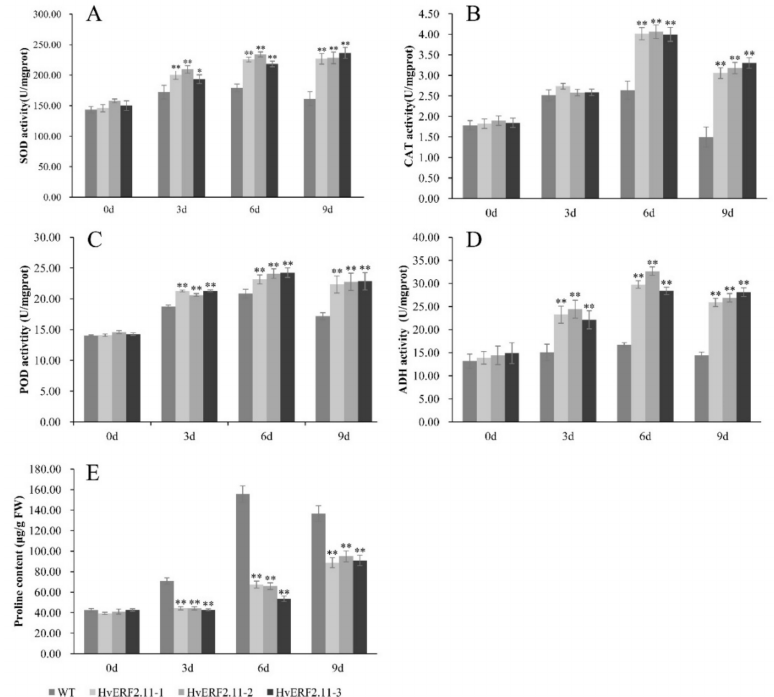
Figure 6. Analysis of SOD, CAT, POD, ADH activities and proline content were carried out in transgenic lines and WT under waterlogging stressed conditions. SOD, CAT, POD, ADH and proline levels. ( A–E ) were measured in the leaves of plants subjected to waterlogging stress 3 days, 6 days, 9 days. The mean value and standard deviation were obtained from three independent experiments. The data represent mean ± SD of three biological repeats with three measurements per sample. Asterisks indicate significant di ff erences from WT as determined using Student’s t -test (* p < 0.05; ** p <